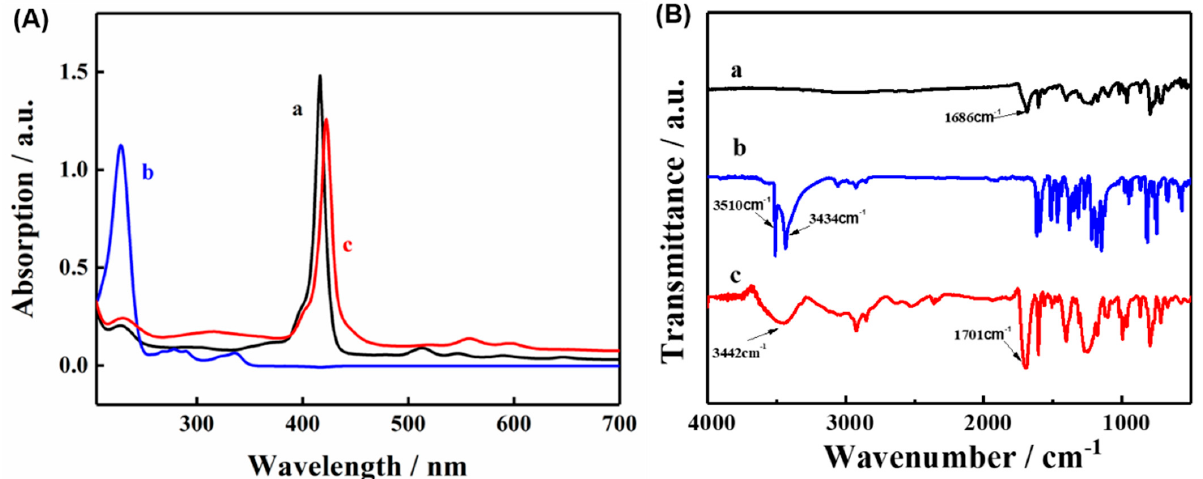
Figure 4. ( A ) UV – vis absorption and ( B ) FTIR spectra of TCPP (a), (S)-BINOL (b), and TCPP-Zn- (S)-BINOL (c). BINOL